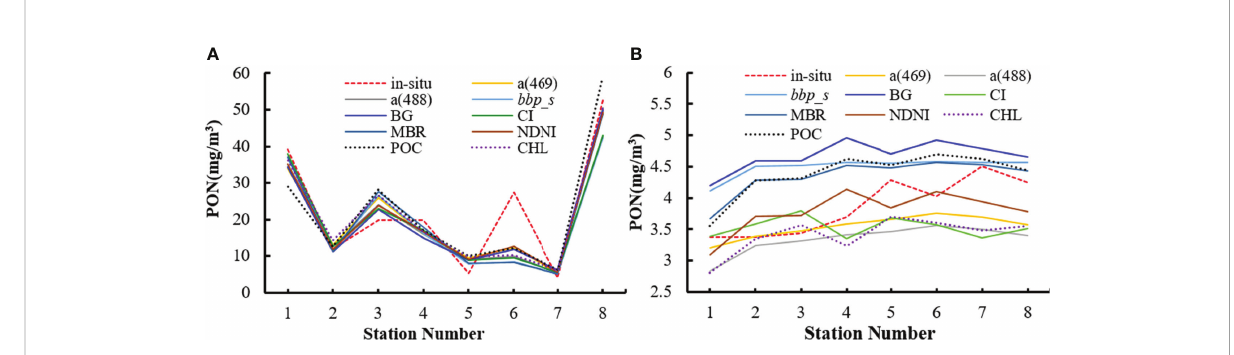
FIGURE 6 The estimated PON concentrations for matchups associated with the in situ data for the west coast of the United States (A) and the Canary Basin (B) ,